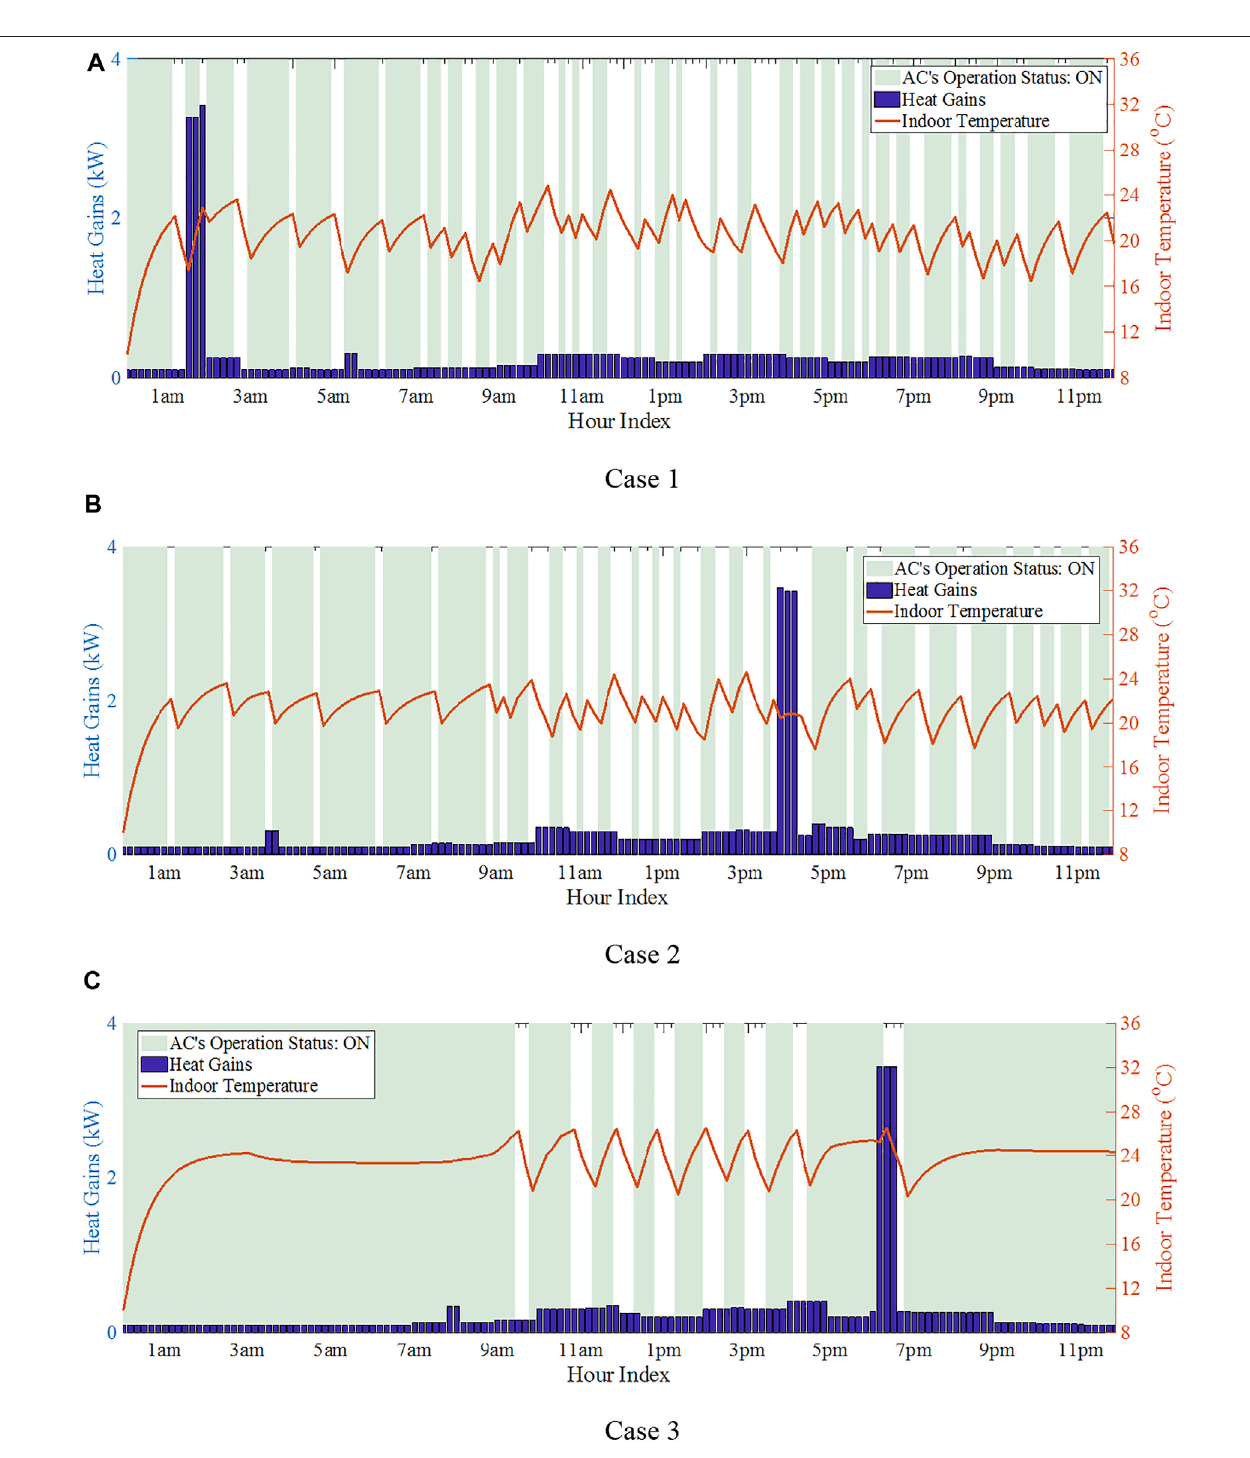
FIGURE 15 | Indoor thermal environment and AC operation